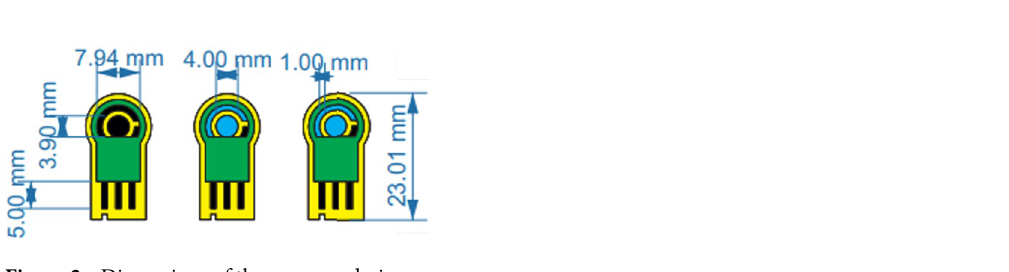
Figure 2. Dimensions of three sensor